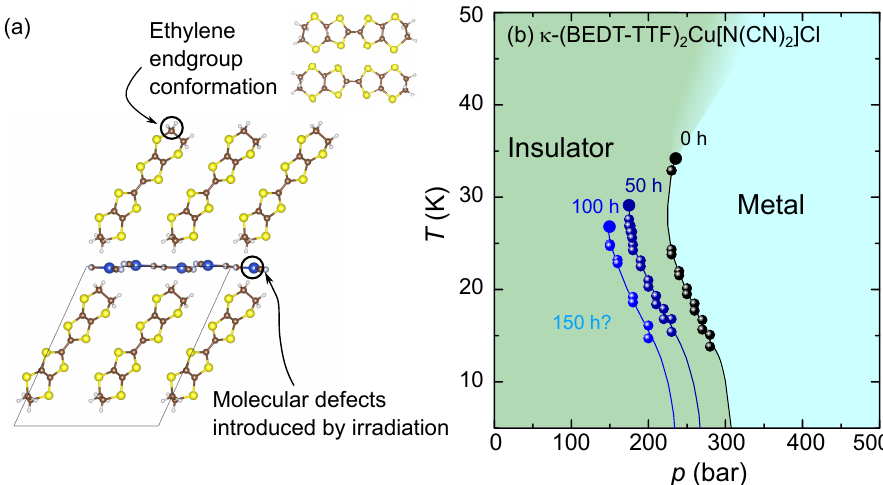
Figure 9. Experimental studies of the impact of weak disorder in κ -phase charge-transfer salts. ( a ) Experimentally, disorder can be deliberately introduced either by (i) creating molecular defects through X-ray irradiation [139] or (ii) by controlling the ethylene endgroup conformation via the cooling rate through the glass-forming temperature T glass [137]; ( b ) temperature–pressure phase diagram for κ -(BEDT-TTF) 2 Cu[N(CN) 2 ]Cl, subjected to different irradiation times [140]. Symbols represent the discontinuous Mott metal–insulator transition. ( b ) adapted from Ref.